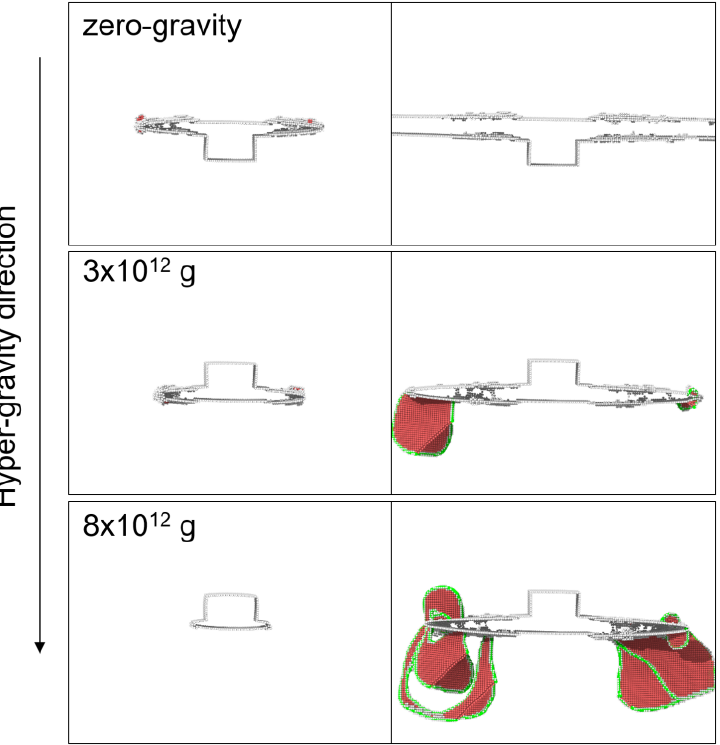
Figure 8. The microstructure evolution of [001](010) crack tip at 1 K and different hyper-gravity intensities. The red and grey color indicate HCP and unidentified structures, respectively. FCC atoms have been deleted for the clarity of the picture.